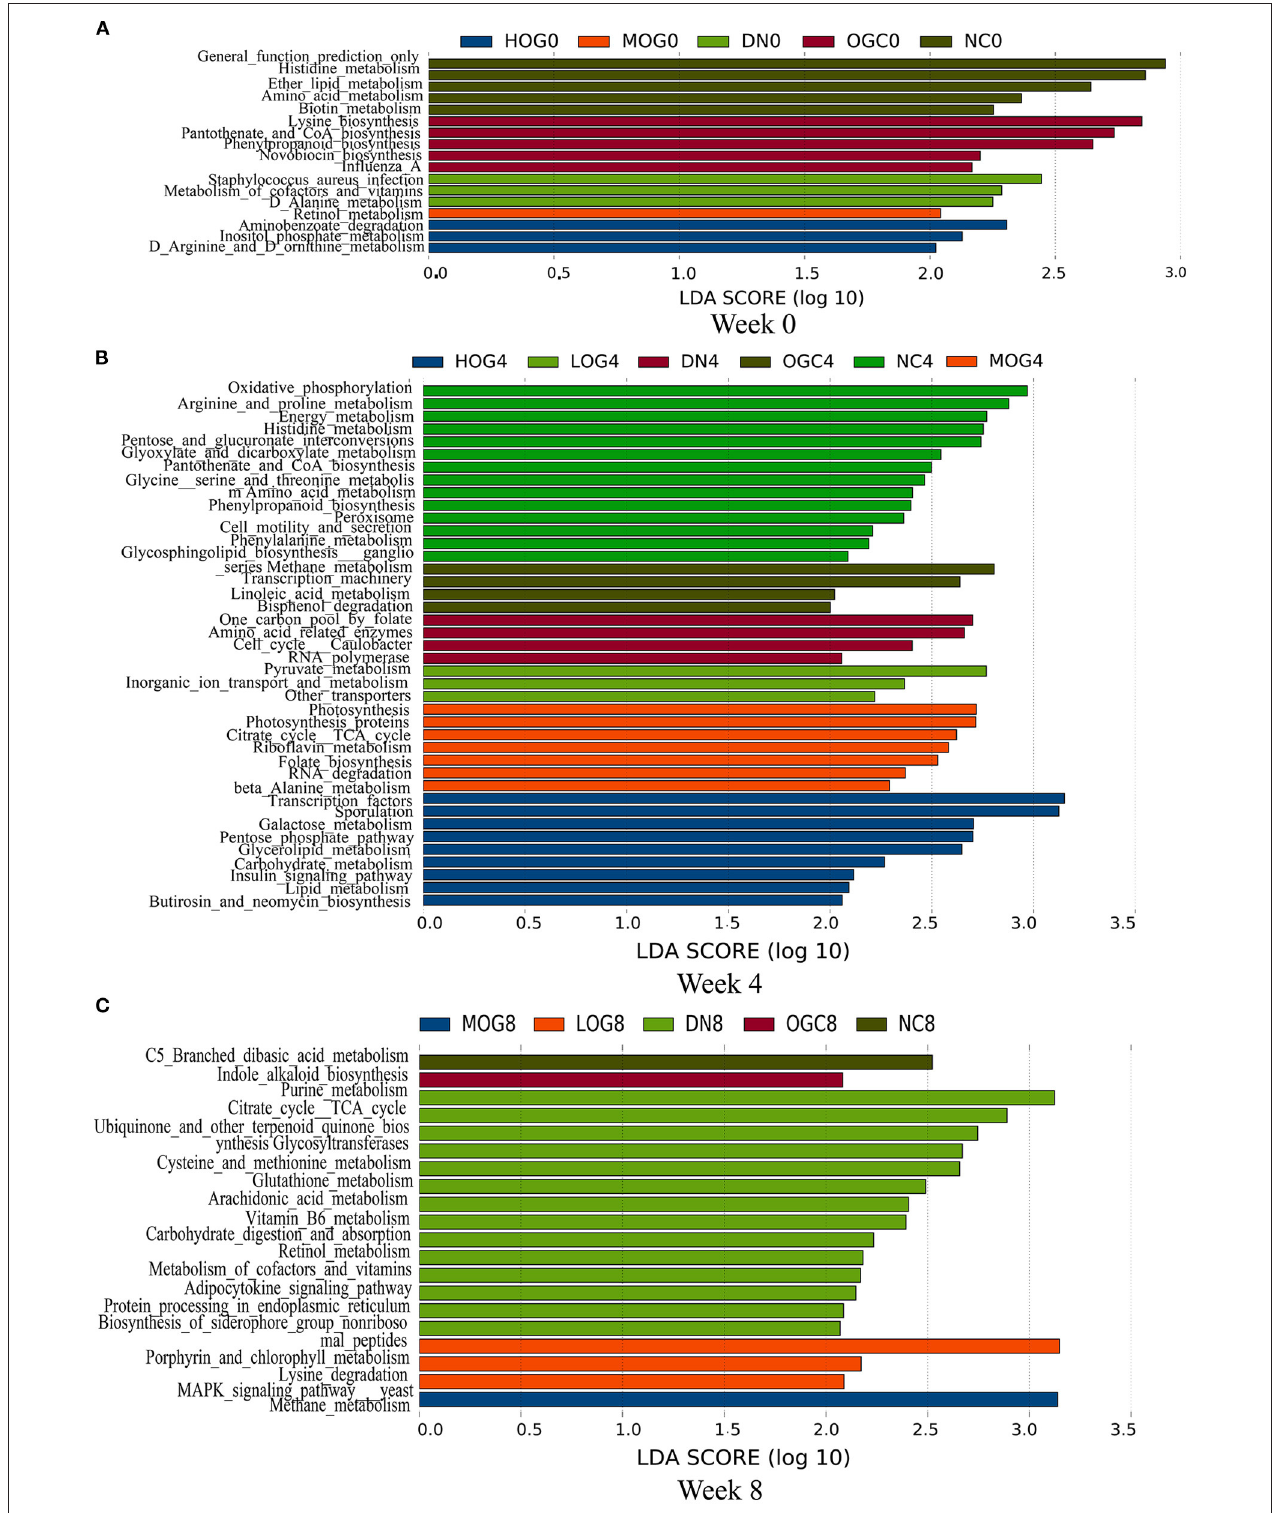
FIGURE 11 | Gut microbial gene functions of the rats in each group at 0 (A) , 4 (B) , and 8 (C) weeks.